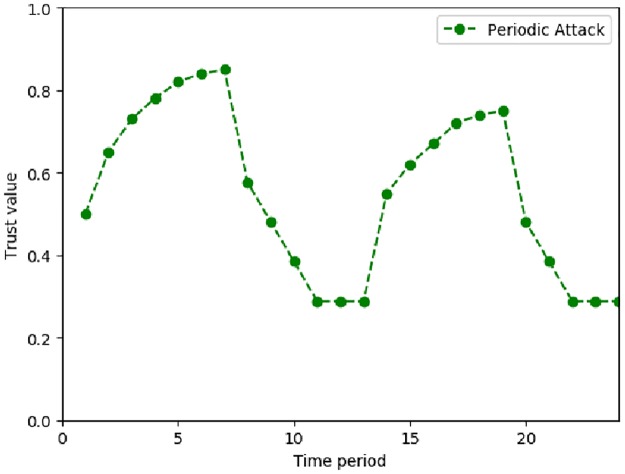
Change trend of node trust value during periodic attacks.